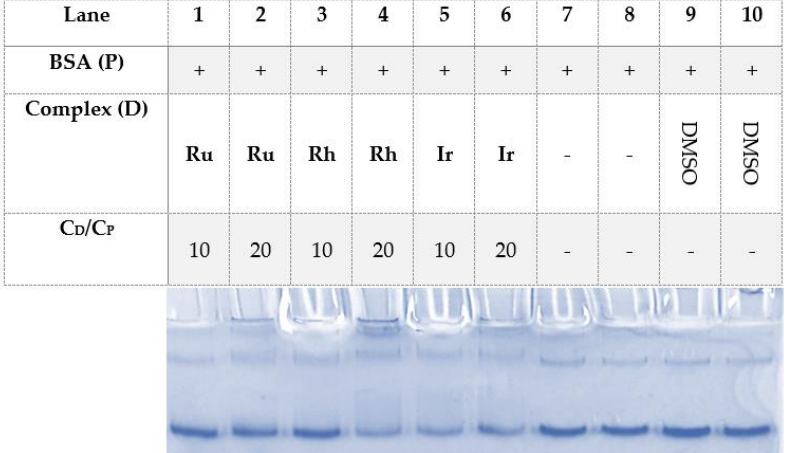
Figure 14. Native PAGE electrophoresis of BSA incubated during 24 h with different concentrations of the L4-M complexes. C P = 1.5 µ M. C D /C P = 10 and 20. C P = BSA concentration; C D = complexes concentration.